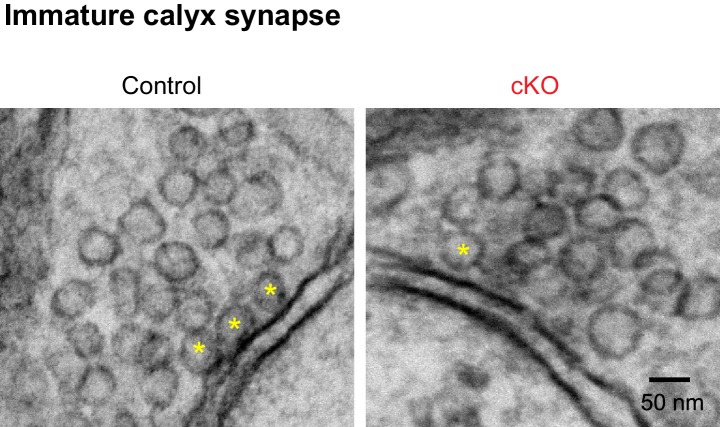
EM image of the immature calyx terminals in the MNTB in control and cKO mice at P10.The active zones are the dense and dark sites in contact with the MNTB cell membrane. Yellow asterisks indicate the docked vesicles within 10 nm of the active zone. Scale bars, 50 nm.